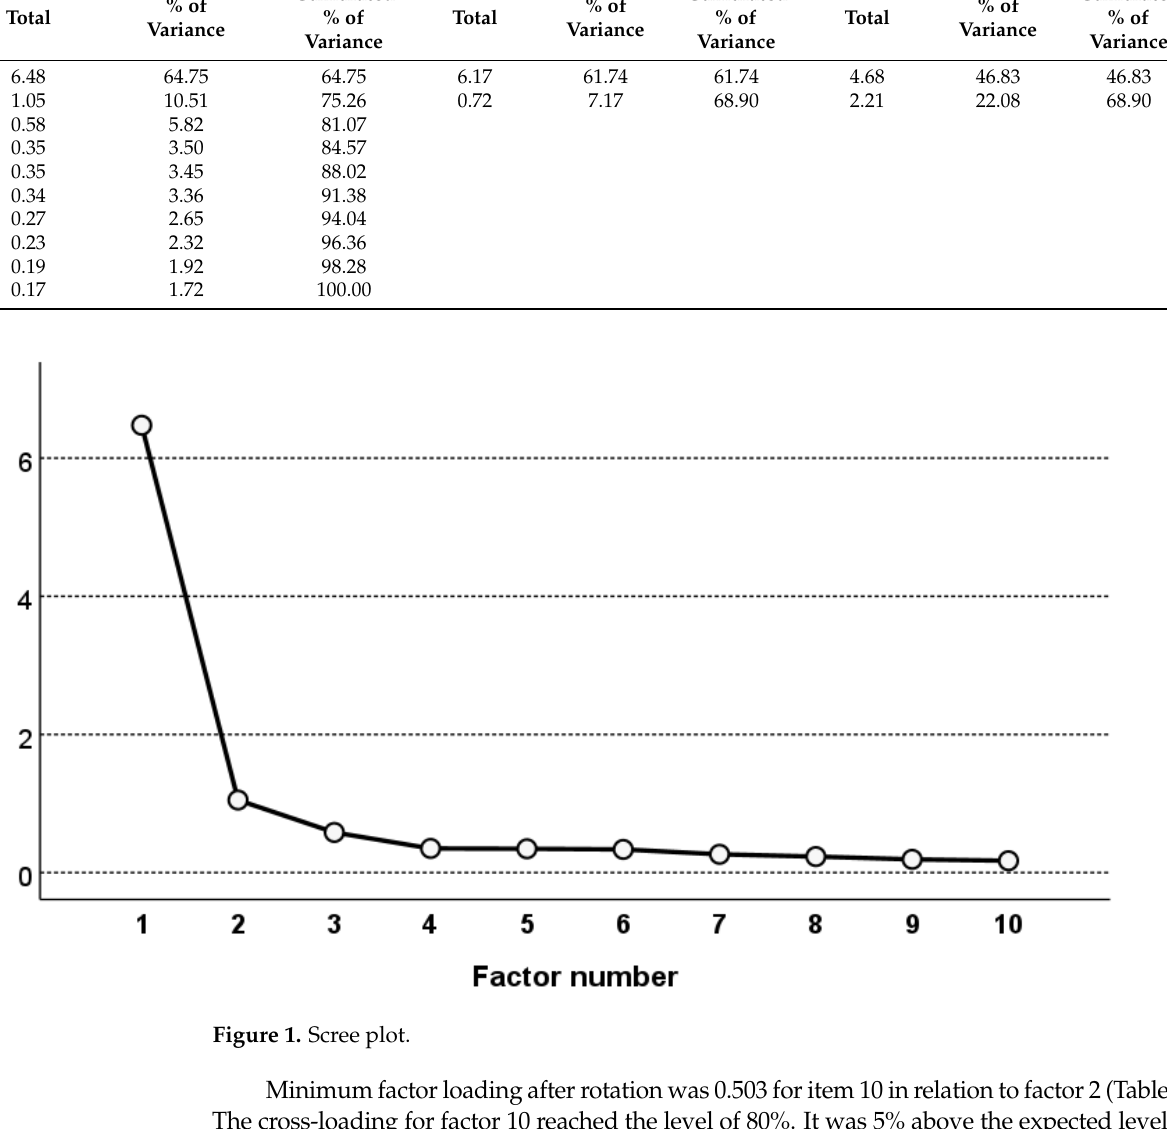
Table 4. Total variance explained by the two-factor latent structure of the scale.